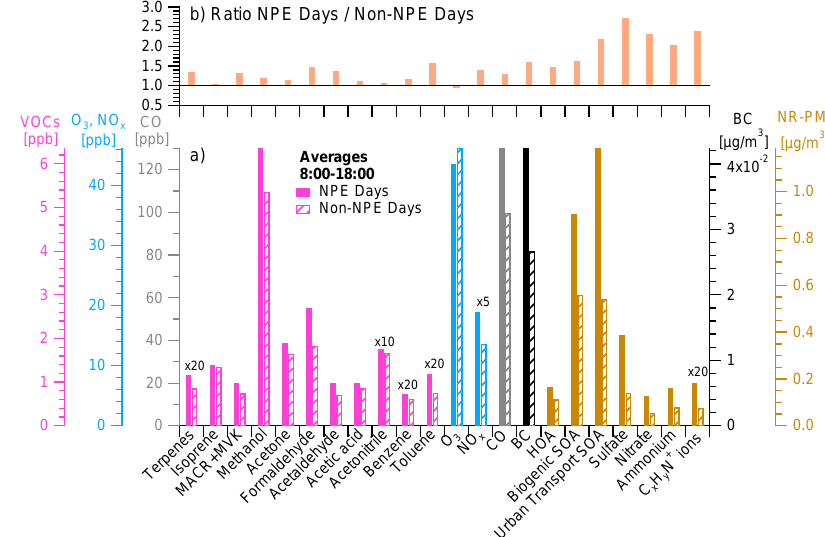
Figure 11. (a) Average concentrations of VOCs, O 3 , NO x , CO, BC, NR-PM 1 species, different factors, and N-containing organic ions ( = CHN + +CH 4 N + +C 2 H 3 N + +C 2 H 4 N + ) between 08:00 and 18:00PDT during NPE and non-NPE days at T1. (b) NPE days/non-NPE days ratios for the same parameters.